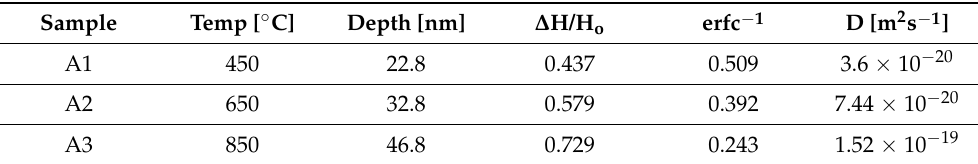
Table 5. Growth rate of the BN phase for the plasma-treated samples in an Ar/N 2 mixture for 600 sec at different RF powers. Referent value of H o = 5.39 GPa.